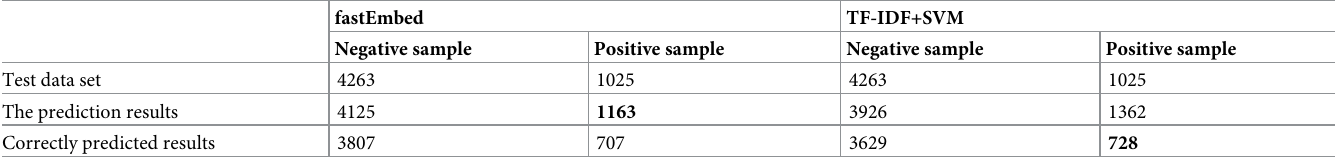
Table 7. Data composition of the test set and prediction results of the models.